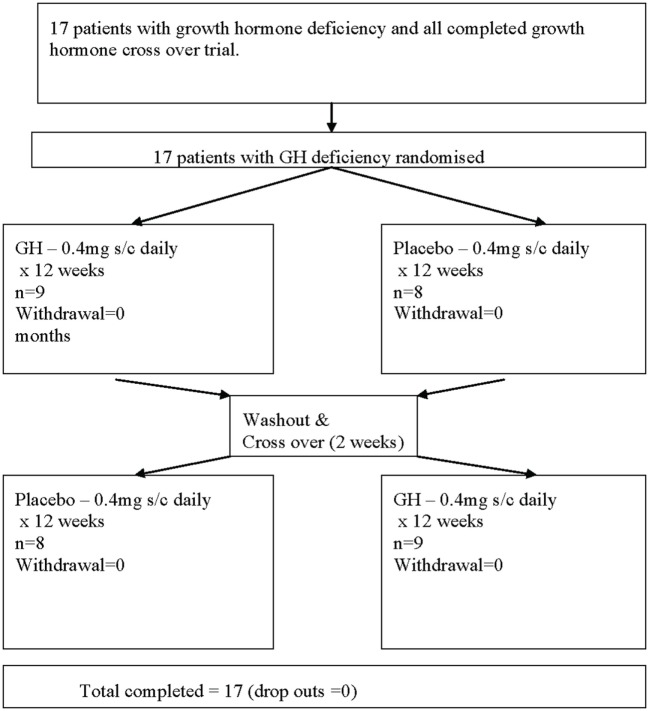
Flow chart describing the progress of patients through the trial.